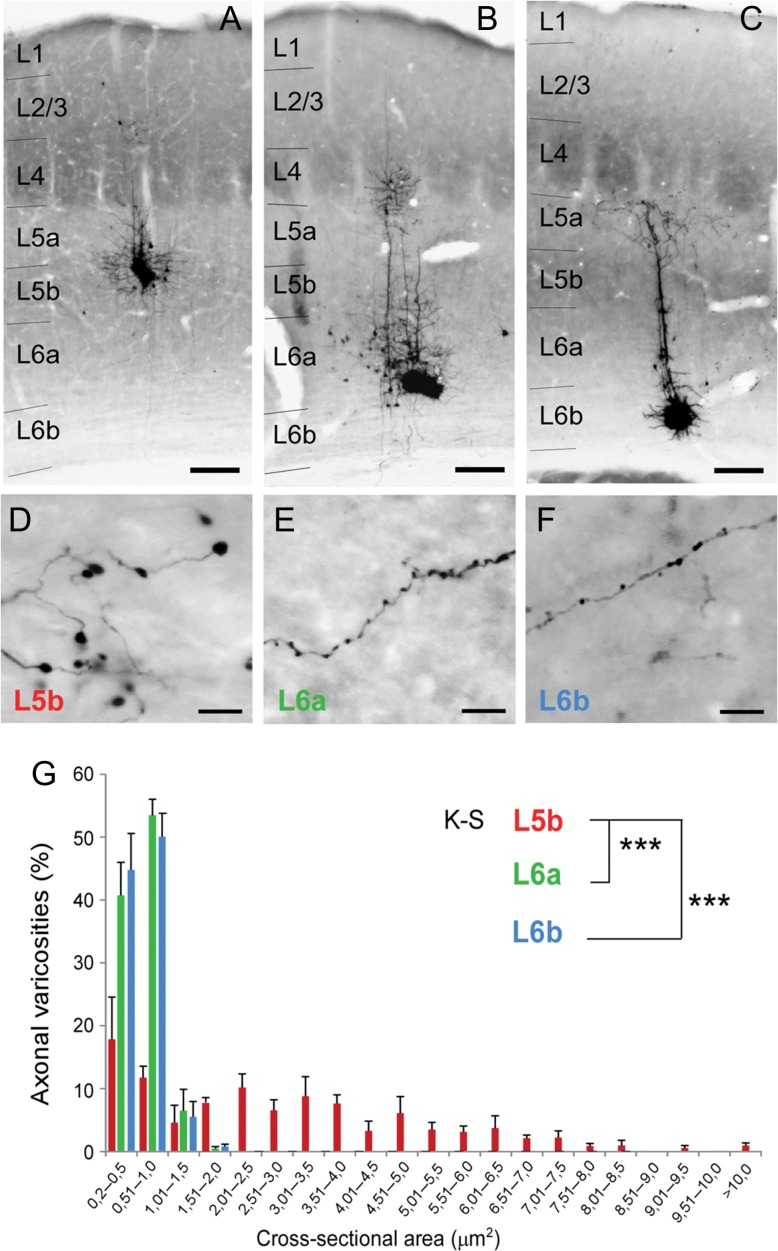

L6b, 6a, and 5b cortical neurons have distinct morphologies of axonal varicosities in Po. Photomicrographs showing BDA microdeposits in layer 5b (A), layer 6a (B), or layer 6b (C) in S1BF cortex, and details of their respective labeled axonal arbourizations in Po nucleus (D, E, and F). Cytochrome-oxidase histochemistry counterstain was used to delineate barrels in S1BF. (G) Size distribution of varicosities from L5b, L6a and L6b axons grouped into discrete intervals according to their maximal cross-sectional area. Scale bars: A–C = 150 μm, D-F = 10 μm.